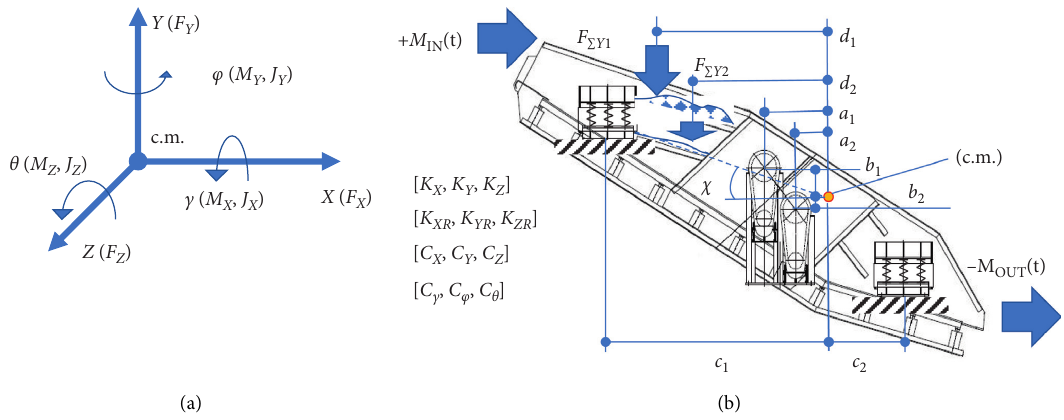
Figure 4: The dynamical model of the vibrating screen: 6-DOF system of coordinates (a); geometrical parameters (b).